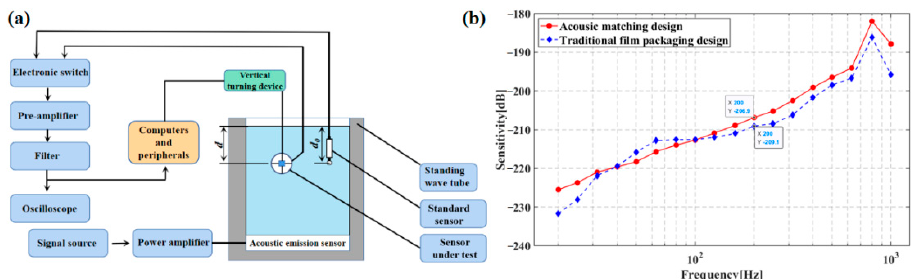
Figure 14. ( a ) Principle of calibrating standing-wave tube. ( b ) Acoustic encapsulate sensor low-frequency linear curve.